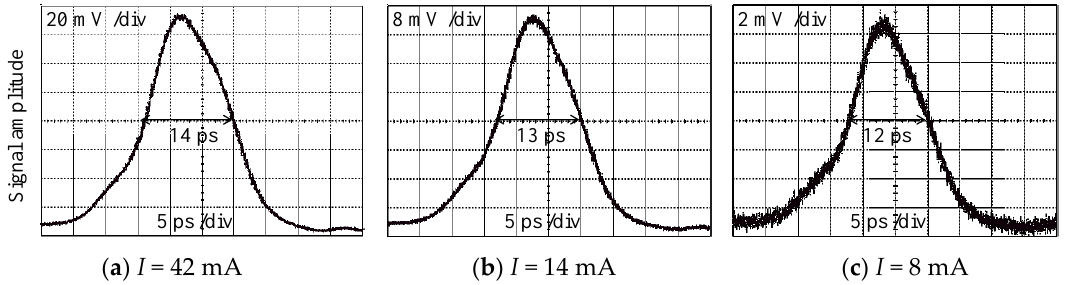
Figure 5. Experimentally recovered OCDMA auto-correlation by the OCDMA decoder for the fibre link temperature T = 50 ° C and SOA bias current set to: ( a ) I = 42 mA (FWHM width = 14 ps); ( b ) I = 14 mA (FWHM width = 13 ps); and, ( c ) I = 8 mA (FWHM width = 12 ps), respectively.